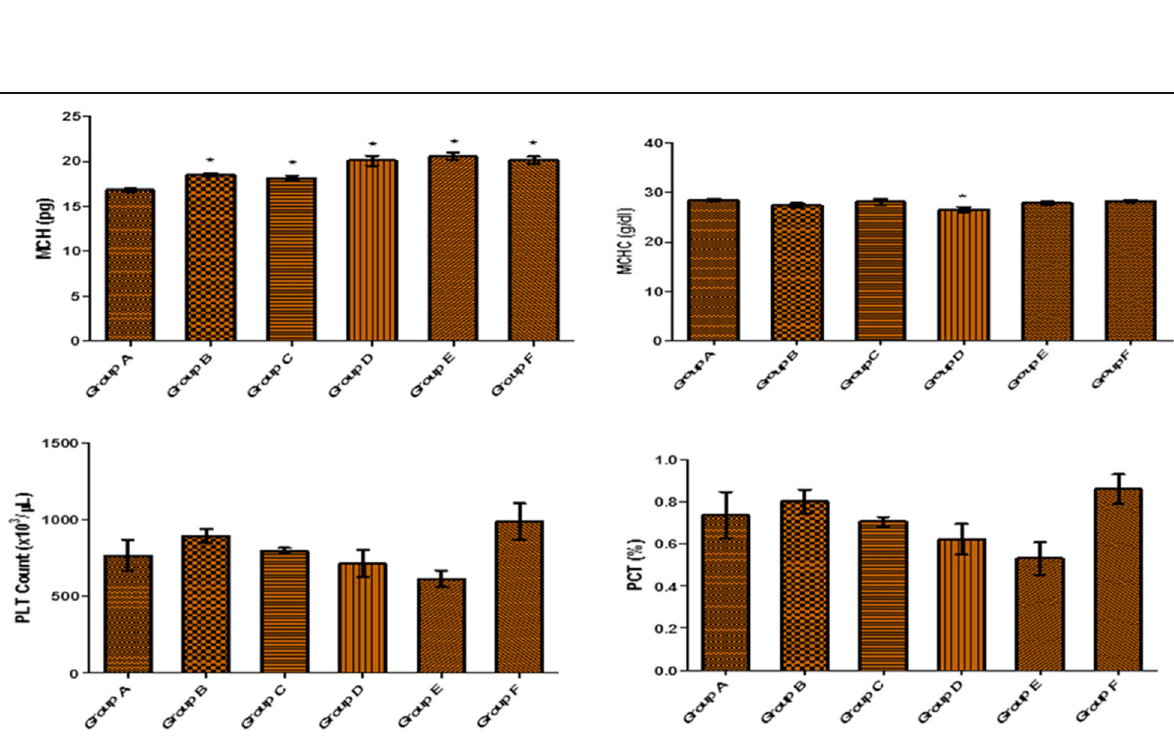
Fig. 4 Bar-charts showing the MCH (Mean Corpuscular Haemoglobin), MCHC (Mean Corpuscular Haemoglobin Count), Platelet count and Plateletcrit following the administration of Spondias mombin extract and PHZ at different